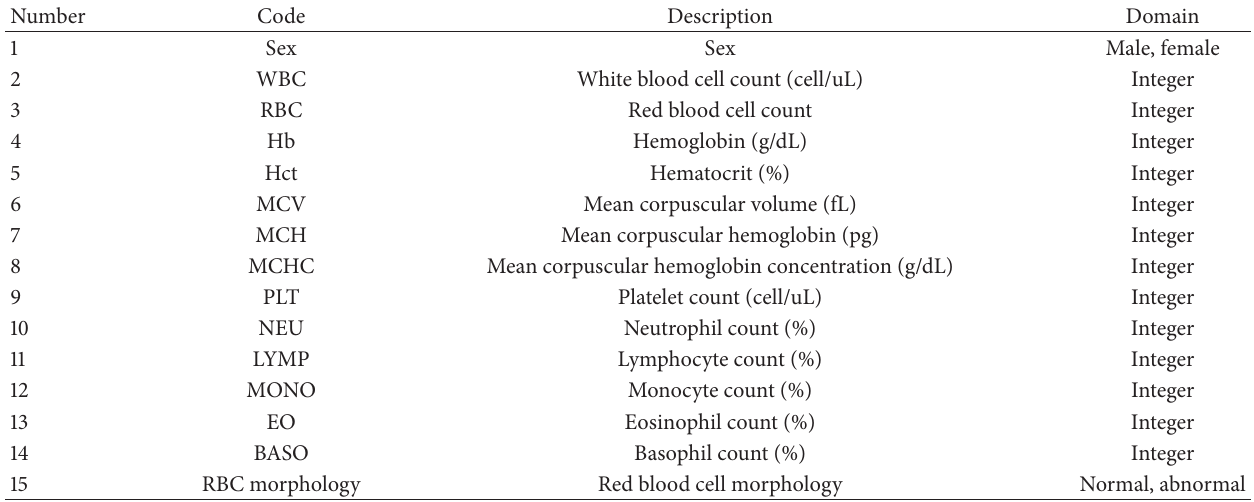
Table 1: The data set in this